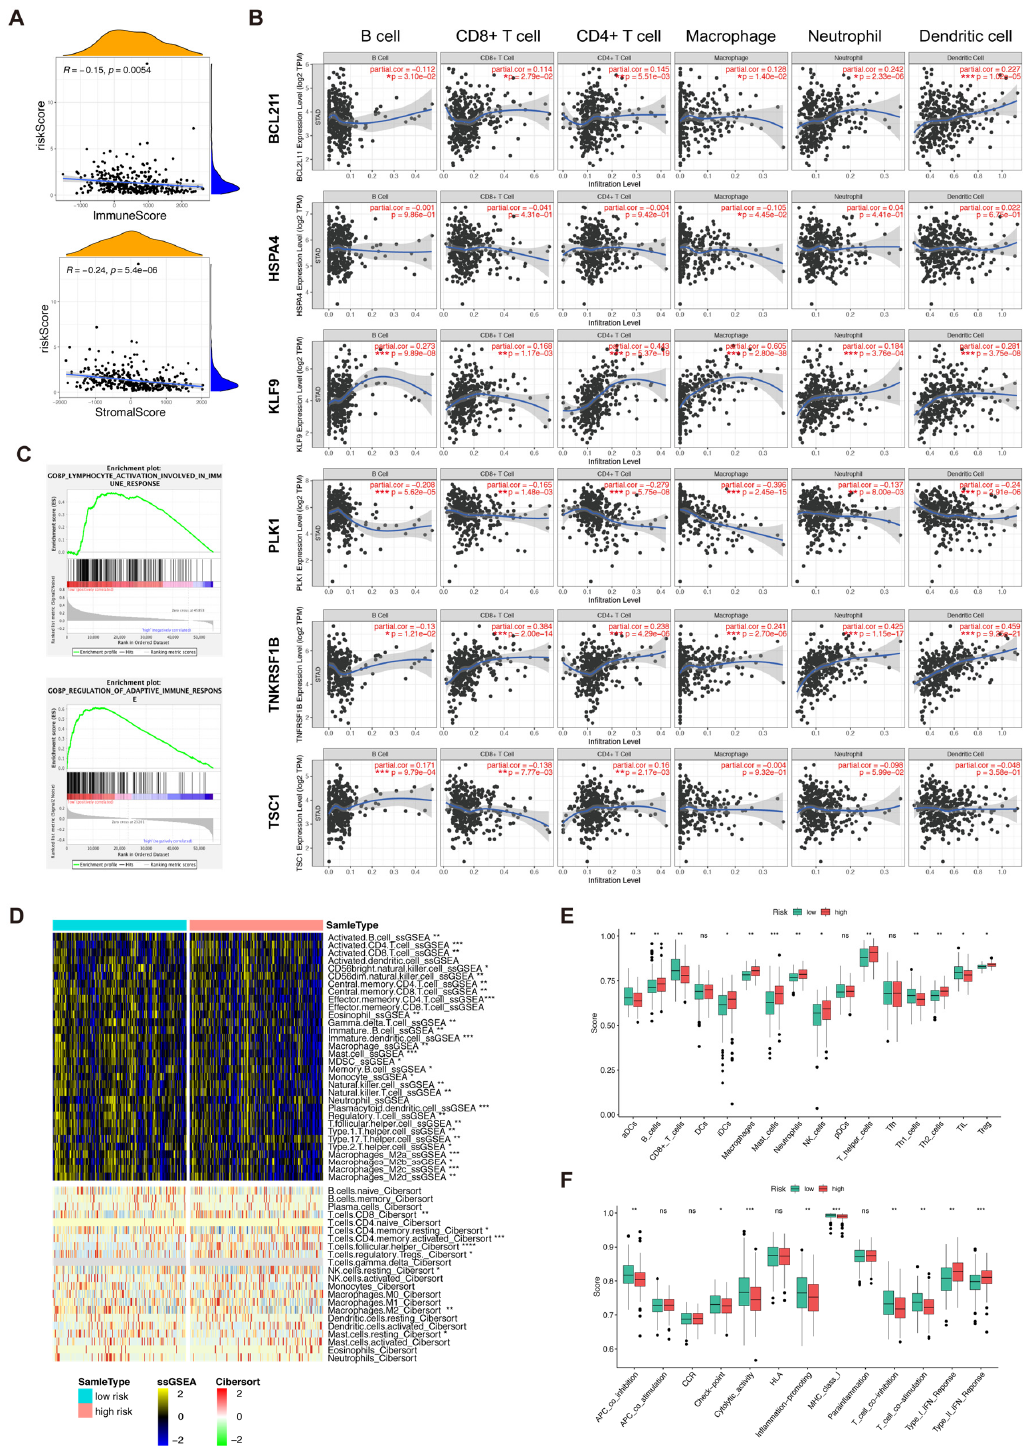
Figure 5. The immune landscape of gastric cancer patients. ( A ). Pearson correlation analysis of immune score and risk score. ( B ). The correlation analysis between 6 prognostic necroptosis-related genes expression and infiltration of six types of immune cells by TIMER 2.0 database. ( C ). GSEA analysis of immune-related gene sets. ( D ). GSVA analysis of immune infiltration based on CIBERSORT and ssGSEA algorithms. ( E , F ). The comparison of 16 immune cells and 13 immune-related pathways ssGSEA analysis between two subgroups (ns = non-significant; *, ** and *** = significant at 0.05, 0.01 and 0.001 levels,